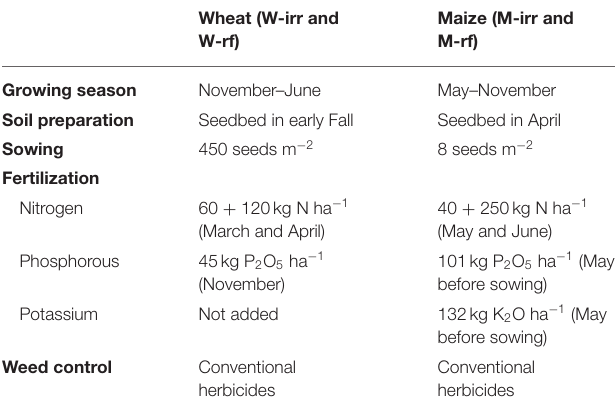
TABLE 1 | Soil and crops management.